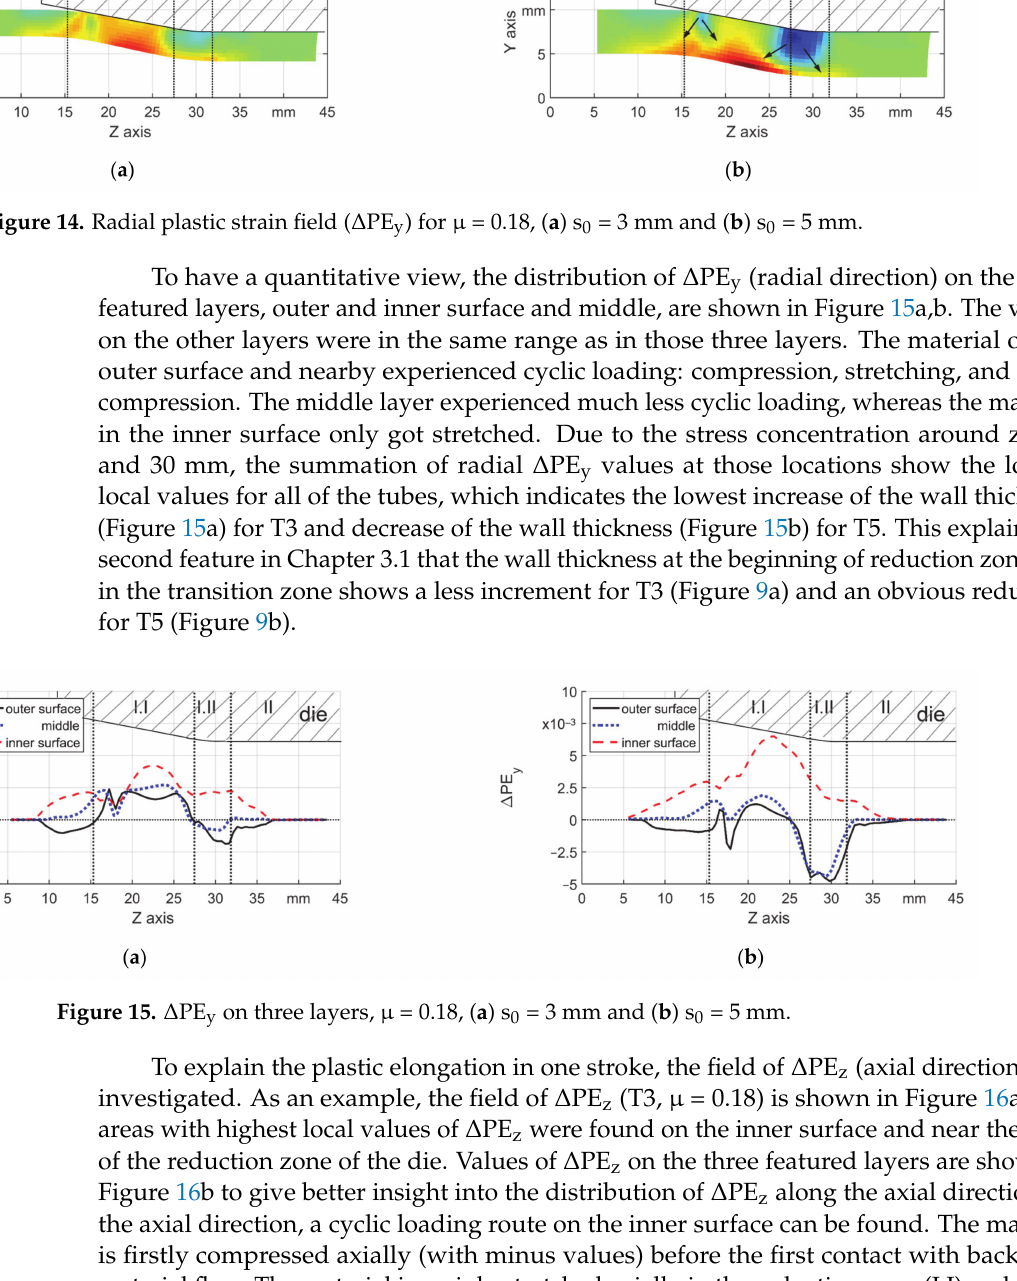
transition zone (I.II) it is compressed again. However, the middle and outer surface were